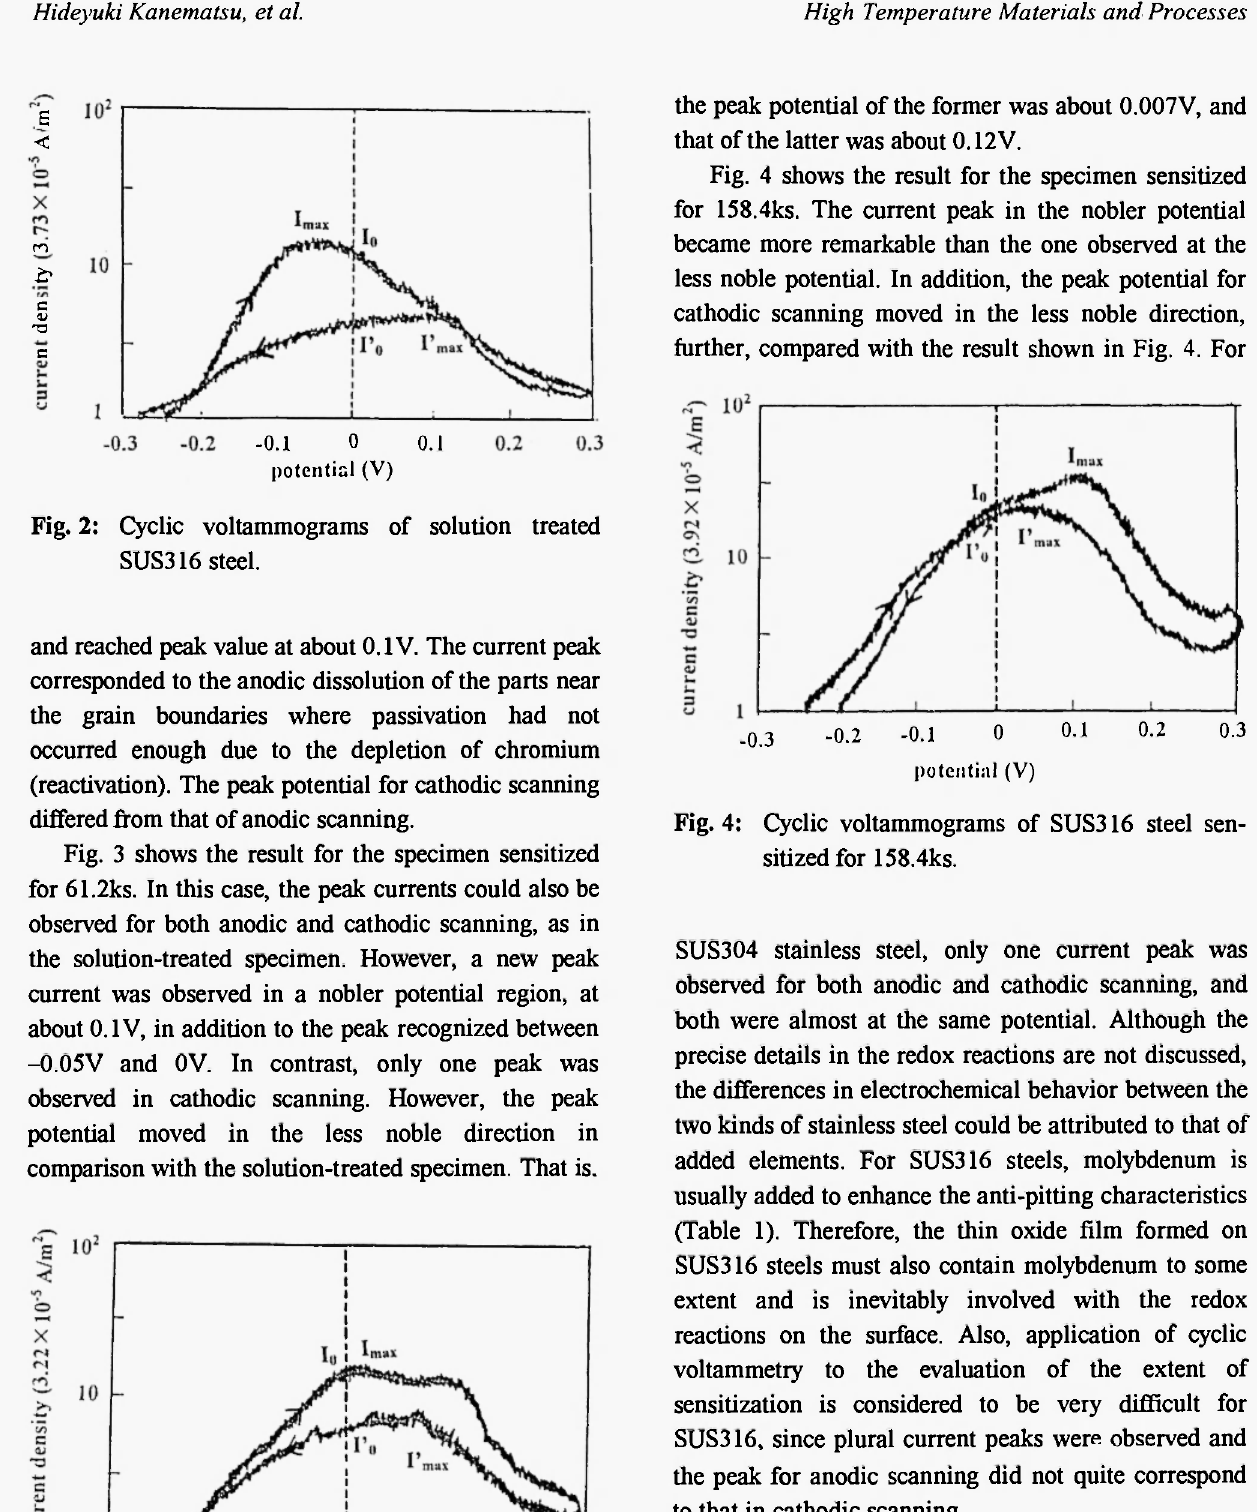
Fig. 3: Cyclic voltammograms of SUS316 steel sen- sitized for 61.2ks.